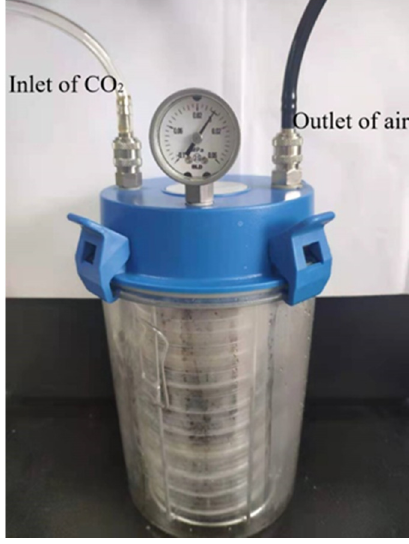
Figure 2. Instruction of anaerobic jar.